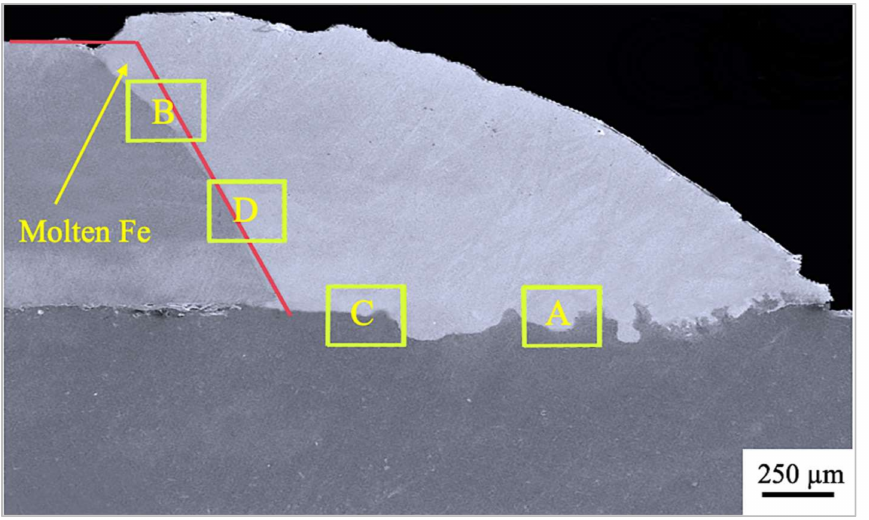
Figure 2. Cross-section of the laser-welded joint. A, B, C and D are the weld zones selected for SEM